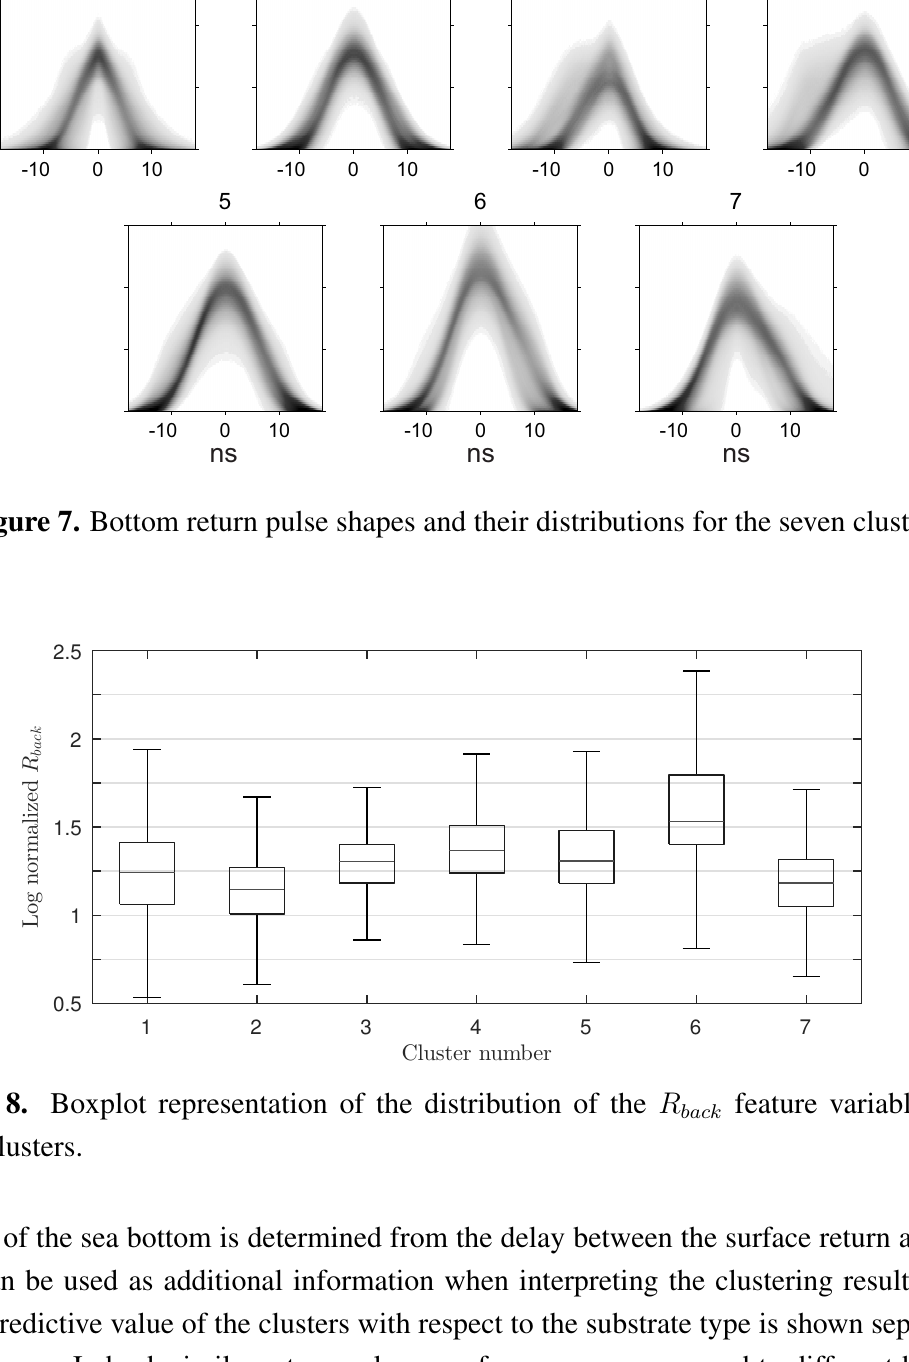
feature variable in the back